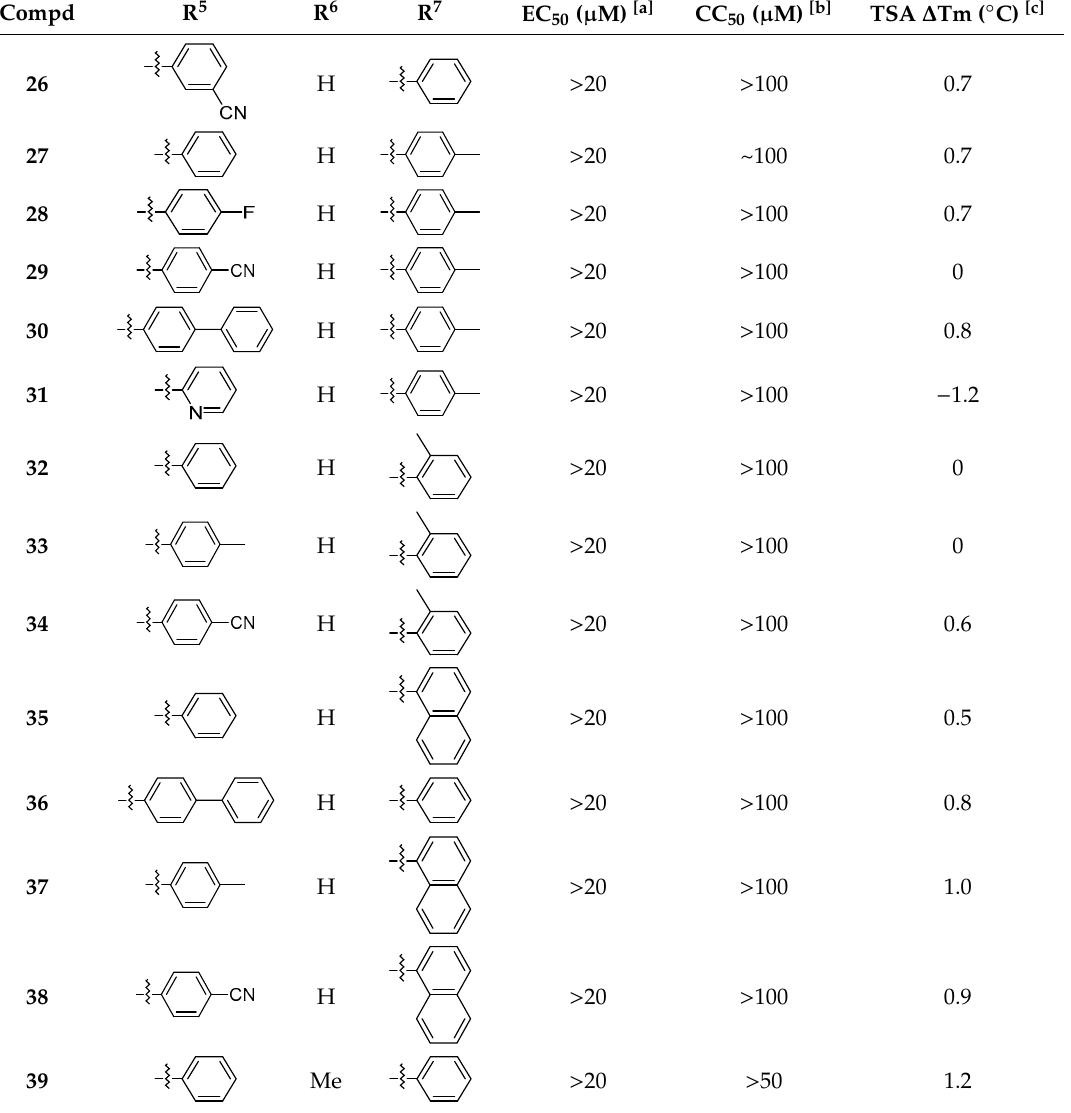
Table 3. Anti-HIV-1 activity, cytotoxicity, and CA hexamer stability profiles of 22–39 (R 5 , R 6 , and R 7 ).